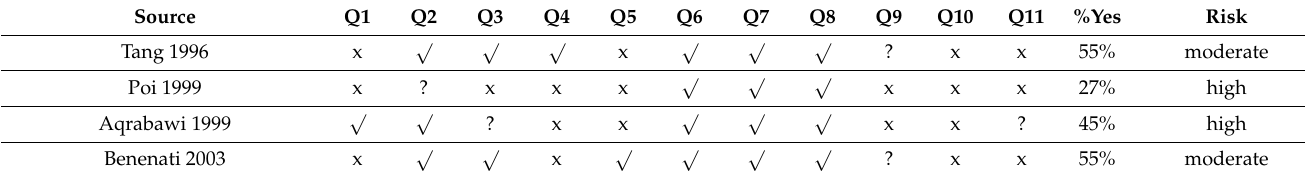
Table 2. JBI Critical Appraisal Tool. Abbreviations: JBI Joanna Briggs Institute; “Q1–Q11